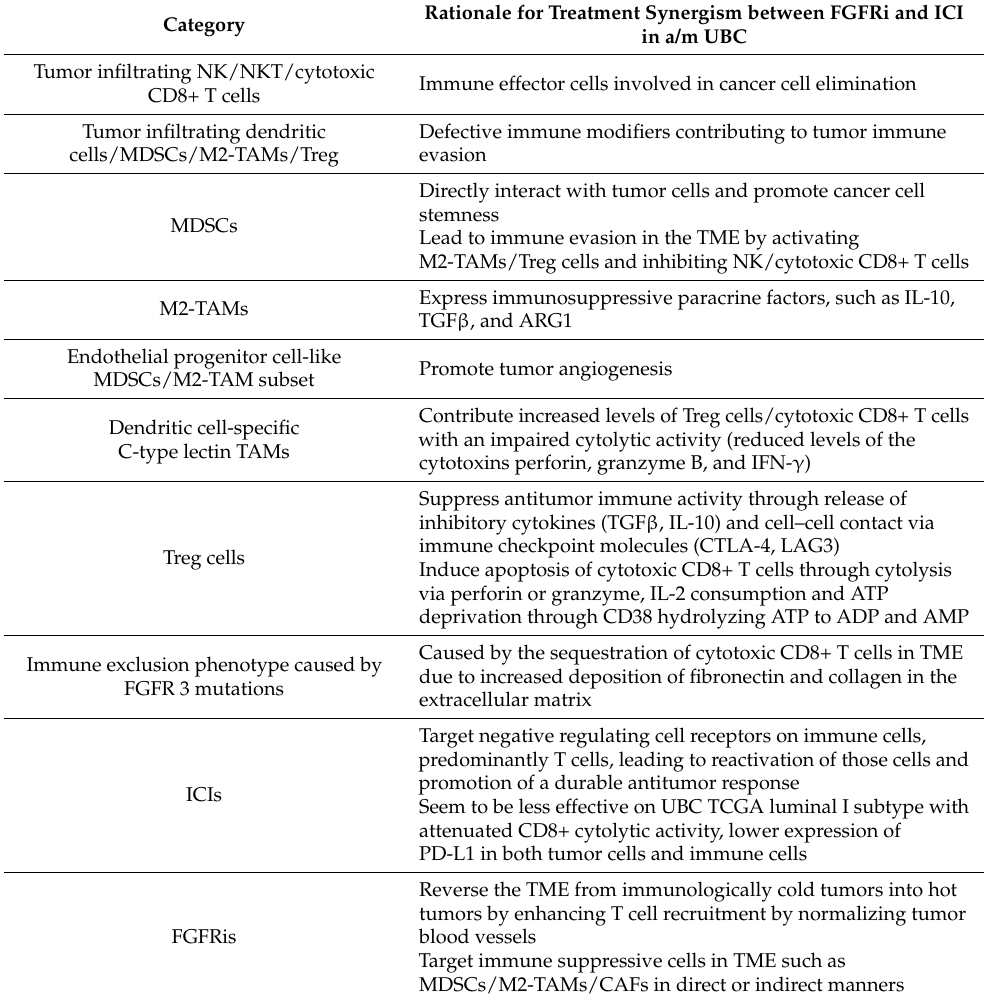
Table 2. Combinations of FGFRi + ICI: rationale and its